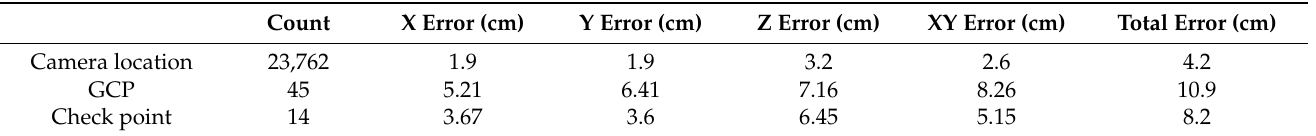
Table 1. Root mean square errors (RMSE) for Control and check points and camera location. Errors are reported in X (easting), y (northing), Z (altitude), XY (cm), and total error